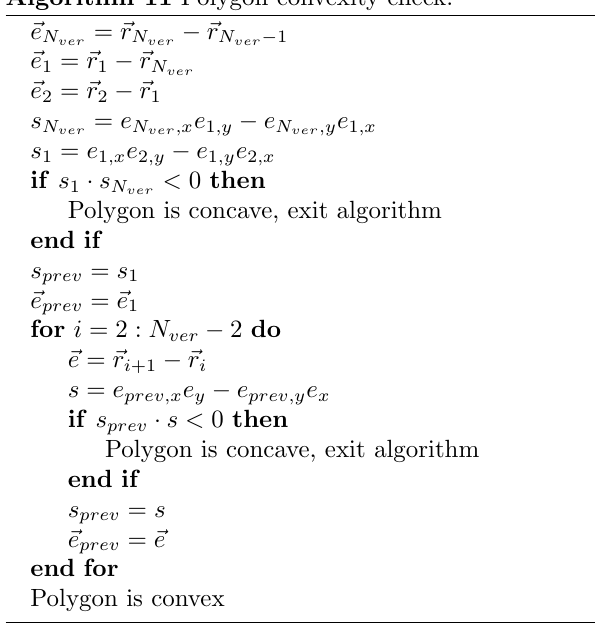
Algorithm 11 Polygon convexity